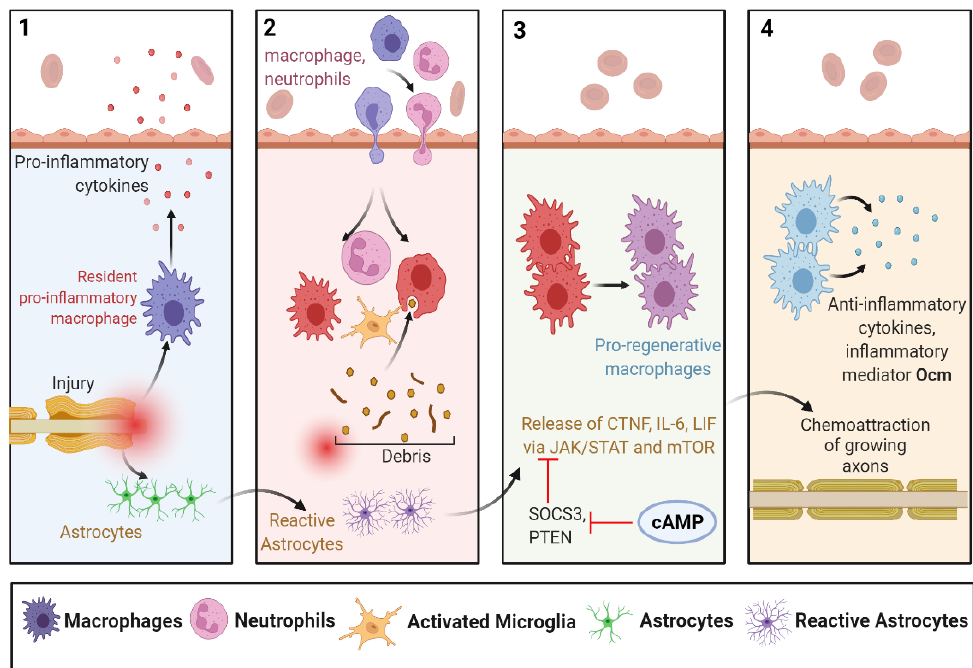
Figure 9. Regeneration by astrocytes/inflammatory mediators. Injury and inflammatory stimuli upon CNS contusion/trauma trigger different pathways and cytokines release. Migration of macrophages and neutrophils toward the injury site, as well as morphological changes of astrocytes promote axonal regeneration. IL-6: interleukin 6; LIF: leukemia inhibitory factor; CTNF: ciliary neurotrophic factor; cAMP: cyclic adenosine monophosphate: PTEN: phosphatase and tensin homolog; SOCS3: suppressor of cytokine signalling 3; Ocm: oncomodulin.